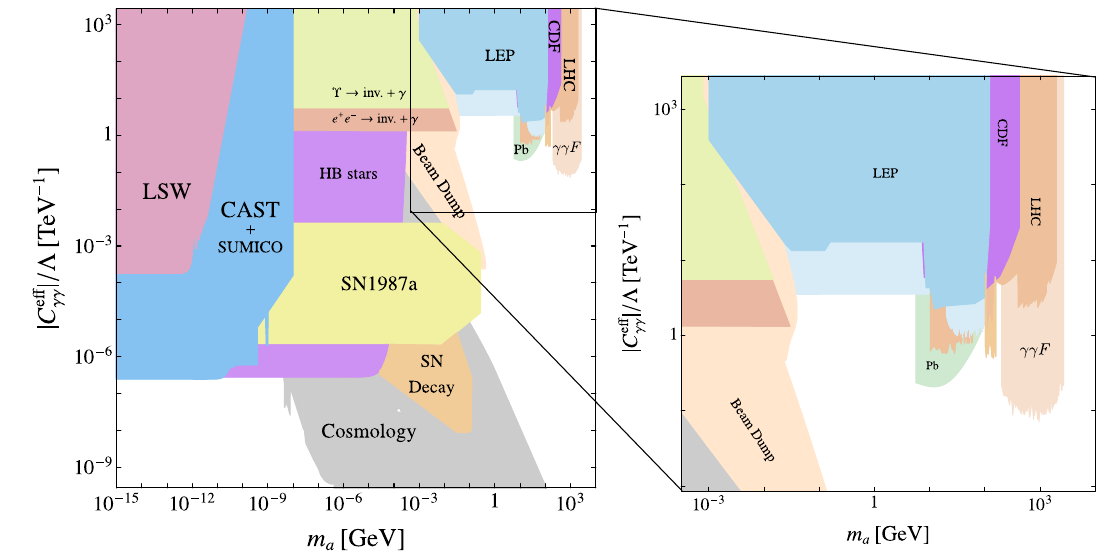
Fig. 4 Left: summary plot of constraints on the parameter space spanned by the ALP mass and ALP-photon coupling. Right: enlarged display of the constraints from collider searches: LEP (light blue and